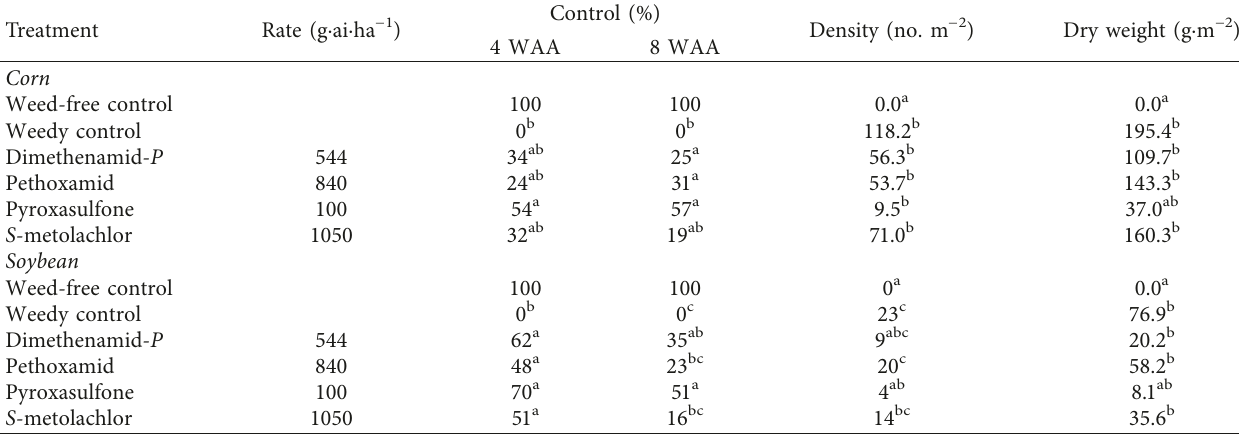
Table 5: Control, density, and dry weight of wild mustard in corn and soybean treated with VLCFA inhibitor herbicides, applied pre- emergence (PRE), near Exeter in 2015 and 2017 a